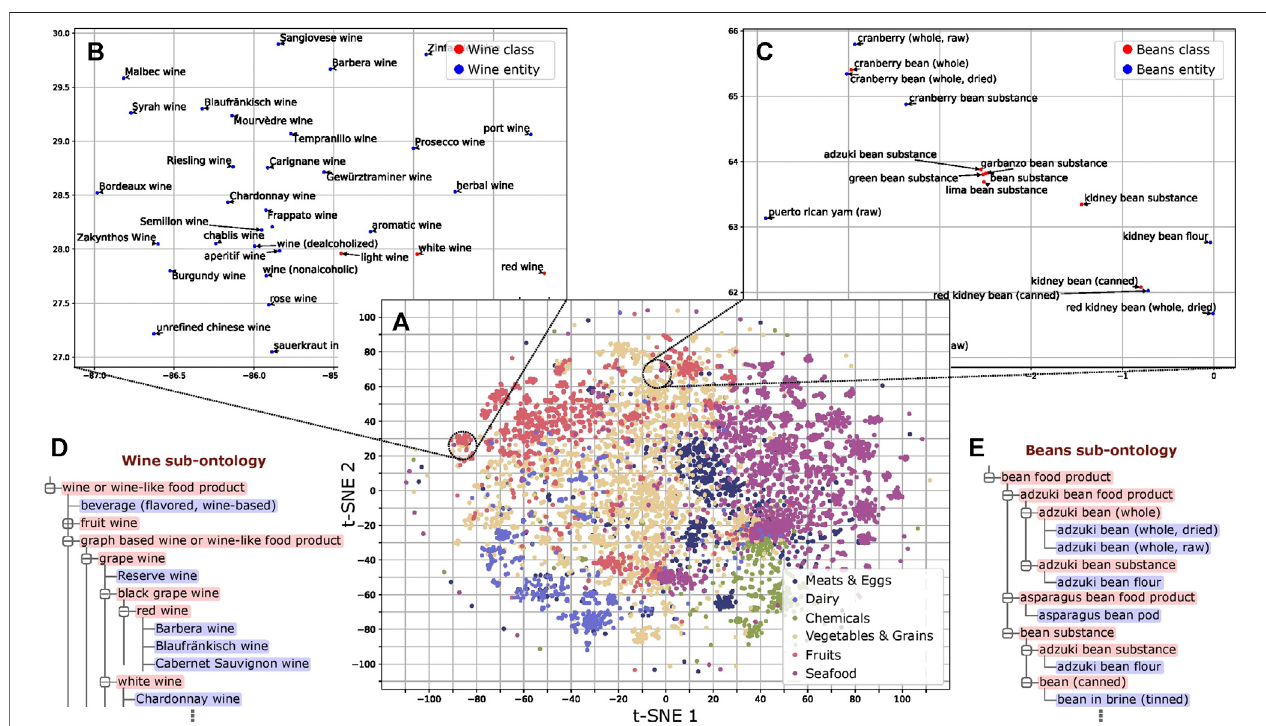
FIGURE 3 | Analysis of word embeddings. (A) t-SNE plot of the FoodOn class and instance labels based on the word embeddings. The distribution pattern of the embeddings shows ordering consistent with that of the FoodOn hierarchy ( p value < 0.0001). (B) Wine subsection follows uniform spatial distribution of instances and classes. (C) Beansubsectionshowsregionalcrowdingofinstances/classesduetotherepetitivewordsinthelabel. (D,E) Wineandbeanrelatedsub-ontologiesasfound in FoodOn, with the bean being signi fi cantly more granular (more classes) than expected. Classes and food instances are highlighted red and blue,